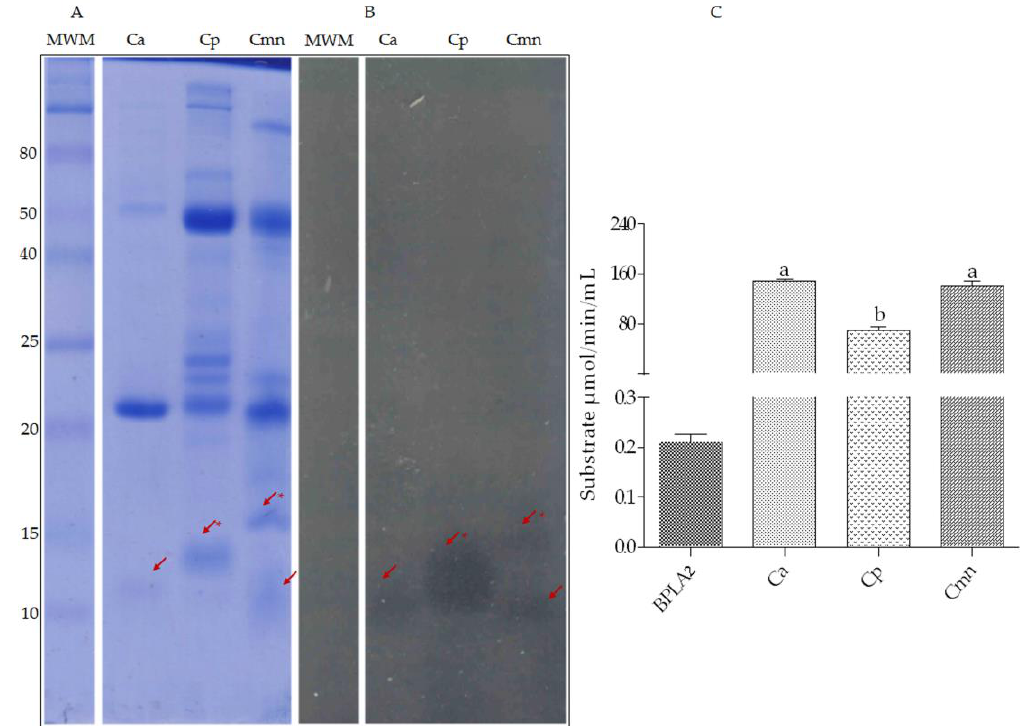
Figure 6. Zymography and enzymatic activity of PLA2. ( A ) 12% SDS-PAGE, ( B ) 4% agarose-egg yolk co-polymerized gel zymography using 20 µ g of protein from C . aquilus (Ca), C. polystictus (Cp), and C . molossus nigrescens (Cmn) venoms incubated after electrophoresis, for 2 h at 37 °C. MWM — molecular weight markers (MW) in kDa. ( C ) Enzymatic activity of 10 μg of bee venom phospholipase (BPLA2) as a positive control and 100 ng from Ca, Cp and Cmn venoms. Small letters (a,b) show statistical differences (Tukey p < 0.05) between samples, positive control was not compared. Red arrows show bands with PLA 2 activity, and red asterisk show bands not shared between the venoms.